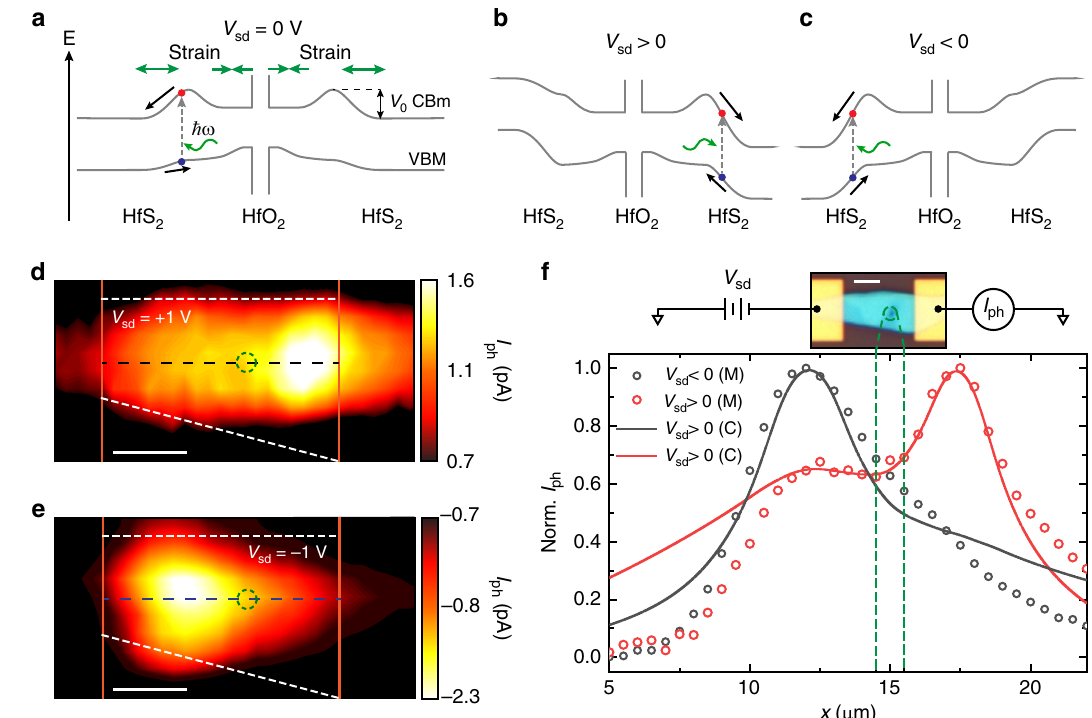
Fig. 4 Charge funnel effect in HfS 2 /HfO 2 engineered devices. a Schematic band diagram of a device subject to strain induced by local oxidation, with V sd = 0 V, according to the proposed geometry in Fig. 1. b , c Schematic band diagrams of the device under V sd > 0 and V sd < 0, respectively. d , e SPCM map of the device under V sd = ±1 V, respectively. SPCM maps were acquired using λ = 473 nm, P = 150 W cm − 2 at V bg = + 30 V. f Normalised photoresponse along the centre of the channel in the SPCM maps in panels d , e (dots) and simulated curves (solid lines) according to Eq. (1). Inset: optical micrograph of the measured device and measurement diagram. Scale bars are 3 μ